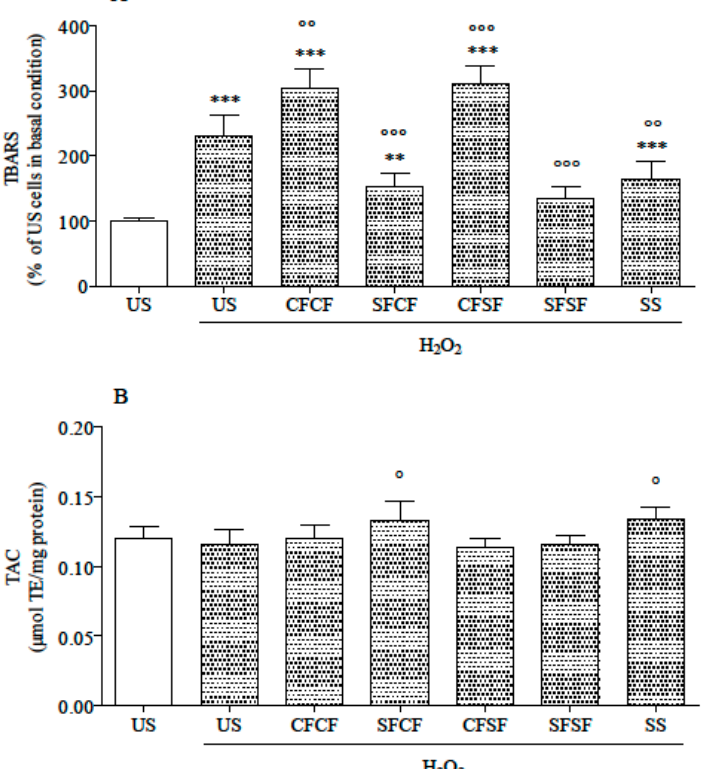
Figure 3. Thiobarbituric acid reactive substances (TBARS) levels ( A ) and cytosolic TAC ( B ) in un-supplemented and supplemented cells. TBARS level (panel A) is expressed as % of the level in US, not stressed cells (assigned as 100%). TAC (panel B) is expressed as µ mol TE/mg protein. All data are means ± SD of at least six samples derived from three independent experiments. Statistical analysis was by one-way ANOVA (A: p < 0.001; B: p < 0.01) using Dunnet’s post-hoc test to compare stressed cells to US, not stressed ones (** p < 0.01; *** p < 0.001), and supplemented stressed cells to US stressed ones ( ◦ p < 0.05; ◦◦ p < 0.01; ◦◦◦ p < 0.001).